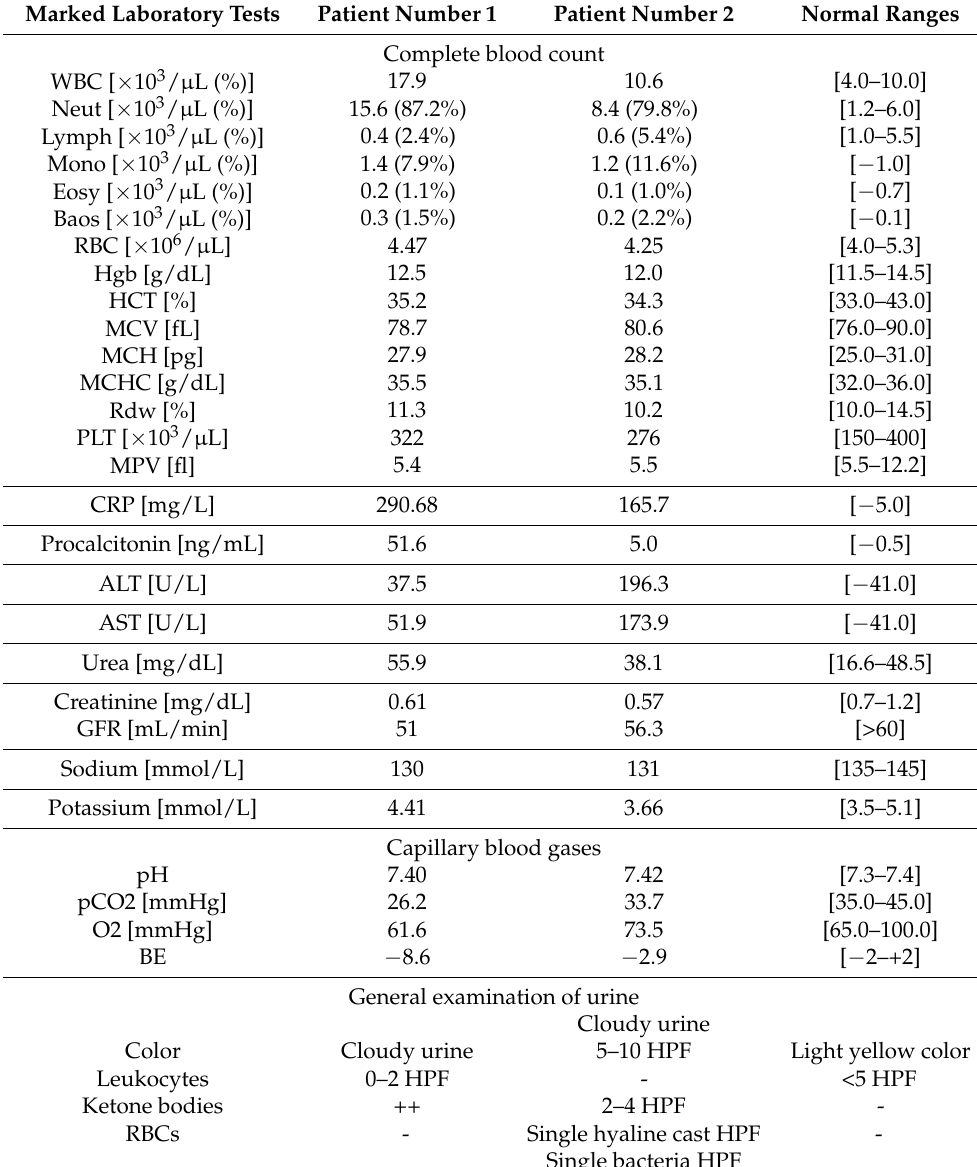
Table 1. Initial diagnosis in the emergency